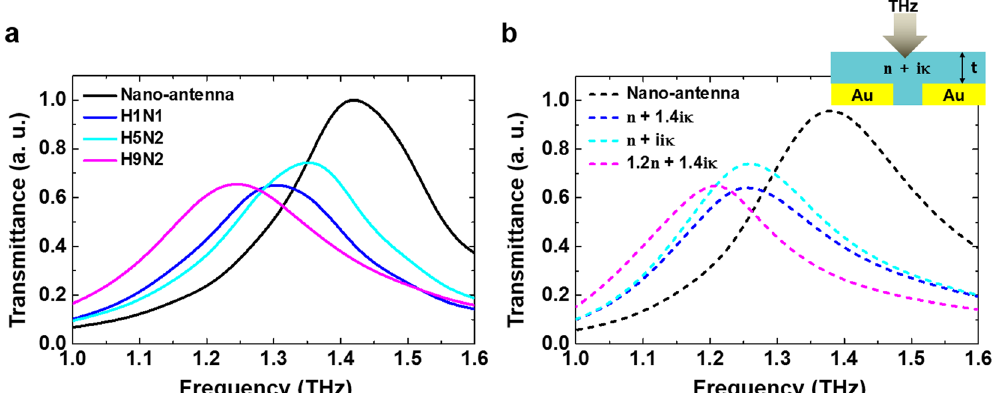
Figure 2. THz optical properties for various types of virus samples. ( a ) Normalized THz transmission spectra measured using the single-resonance nano-antenna without virus sample (black), and with selected three viruses, H1N1 (blue), H5N2 (cyan), and H9N2 (magenta). ( b ) FDTD simulation results of transmittances for the single-resonance nano-antenna and the three different model samples with various composition of dielectric constants ( n and κ ) are shown. Inset indicates a used geometry for simulation.